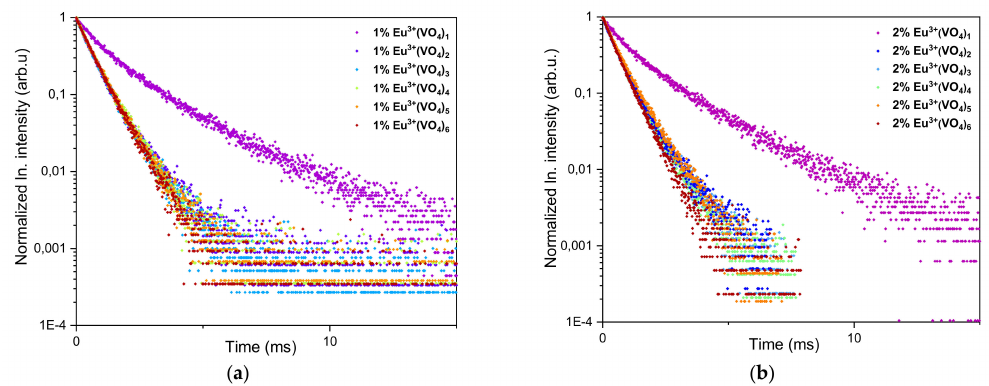
Figure 7. Emission spectra of ( a ) Ca 9.9 Eu 0.1 (PO 4 ) 6 − x (VO 4 ) x (OH) 2 and ( b ) Ca 9.8 Eu 0.2 (PO 4 ) 6 − x (VO 4 ) x (OH) 2 , where x is equal 1, 2, 3, 4, 5, and 6.The excitation wavelength was equal to 396 nm and a 525 nm filter was used in this